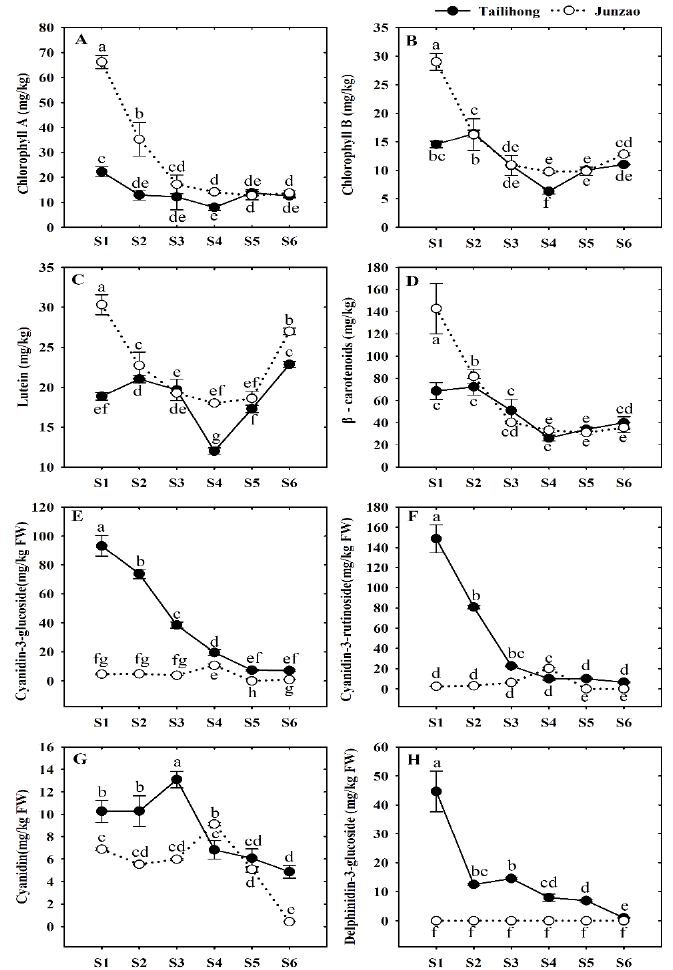
Figure 2. Pigment changes of the skins of the jujube cultivars ‘Tailihong’ and ‘Junzao’. ( A – D ) Contents of chlorophyll a, chlorophyll b, lutein, and β -carotene; and ( E – H ) contents of cyanidin-3-glucoside, cyanidin-3-rutinoside, cyanidin, and delphinidin-3-glucoside. Different letters (a–h) indicate significant differences at p < 0.05 by Duncan’s test. Developmental stages S1–S6 correspond to days 30, 50, 80, 90, 100, and 110 after anthesis.